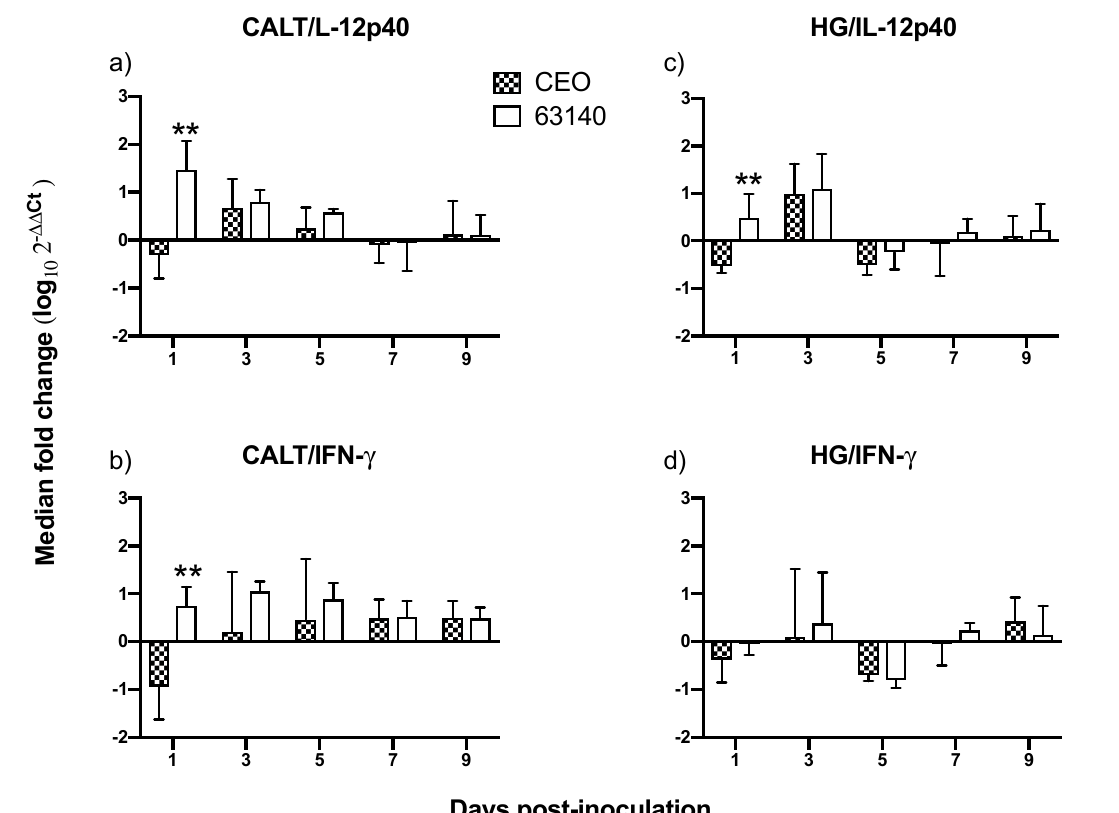
Figure 8. The transcription of IL-12p40 and IFN- γ genes in conjunctiva-associated lymphoid tissue (CALT) and Harderian gland of chickens inoculated via the ocular route with CEO vaccine strain and virulent 63140 strain. The median fold change (log 10 2 − ∆∆ C t ) for IL-12p40 transcription in the CALT ( a ) and in the HG ( c ), and transcription of the IFN- γ gene in the CALT ( b ) and HG ( d ) are presented as the median (bars) with 95% confident interval (lines). Differences in median fold changes for IL-12p40 and IFN- γ between CEO and 63140 groups were determined by non-parametric Mann–Whitney U test ( p ≤ 0.05). Significant increase ( p ≤ 0.05) is indicated by (**).